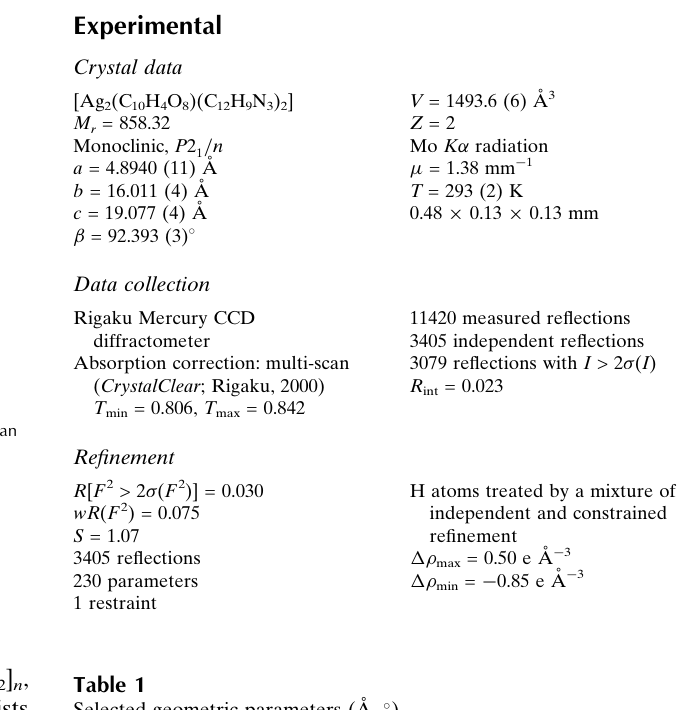
Selected geometric parameters (A˚ , (cid:2) ).